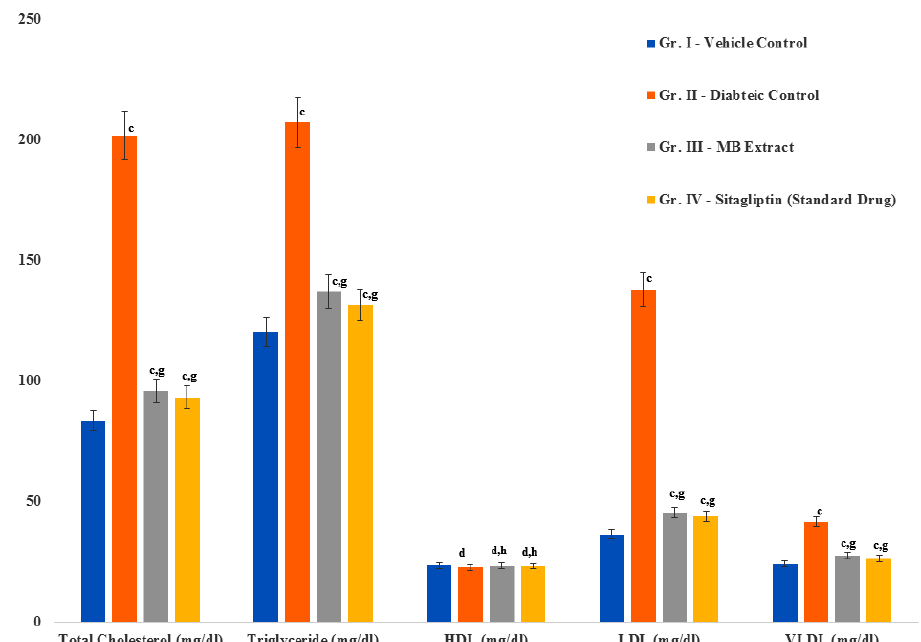
Figure 7. Alterations in the lipid profile of diabetic rats treated with DBT34 microbial extract and sitagliptin. Data are the mean ± S.E.M. ( n = 5); Significant di ff erences between treatment and control groups are indicated by the letters c ( p ≤ 0.001); and d indicates a non-significant di ff erence between the control and treatment groups. g ( p ≤ 0.001); and h indicates a non-significant di ff erence between the treatment groups and the hypercholesterolemic control group.